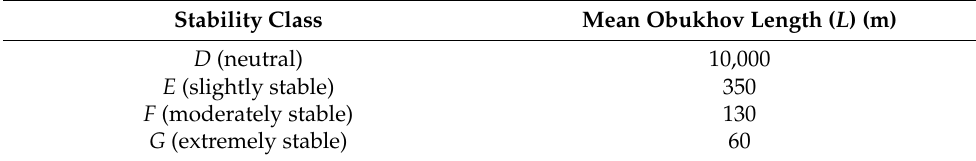
Table 6. Mean Obukhov length described as the stability measure